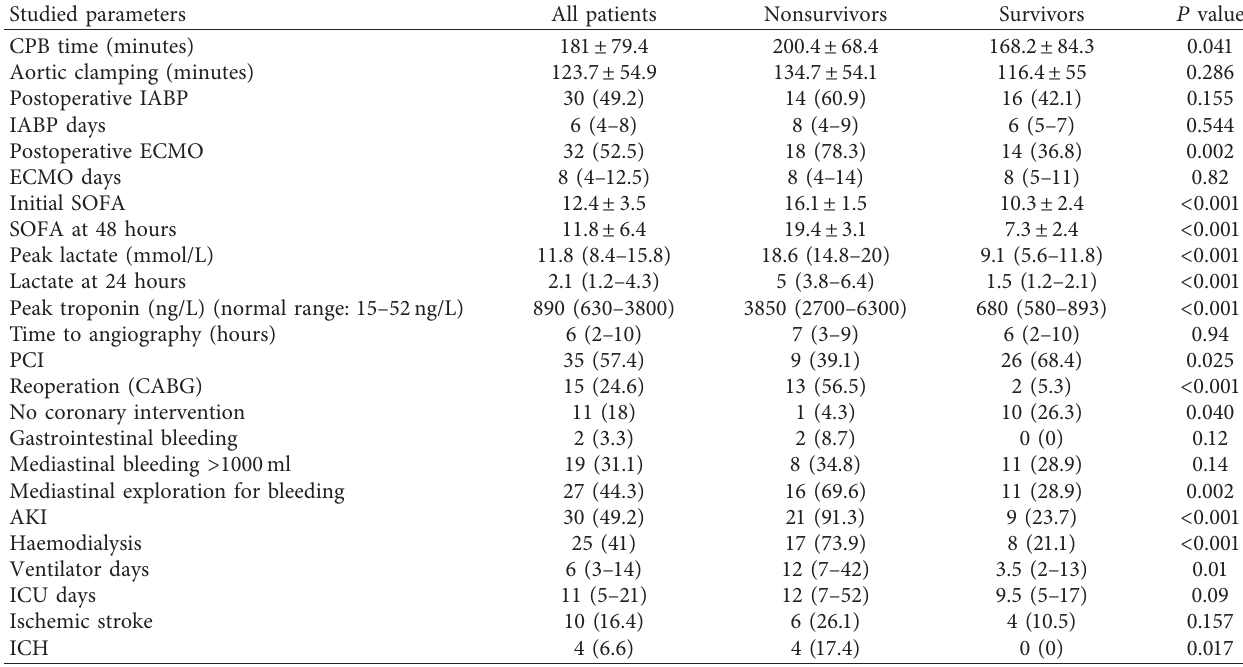
Table 2: Operative and ICU